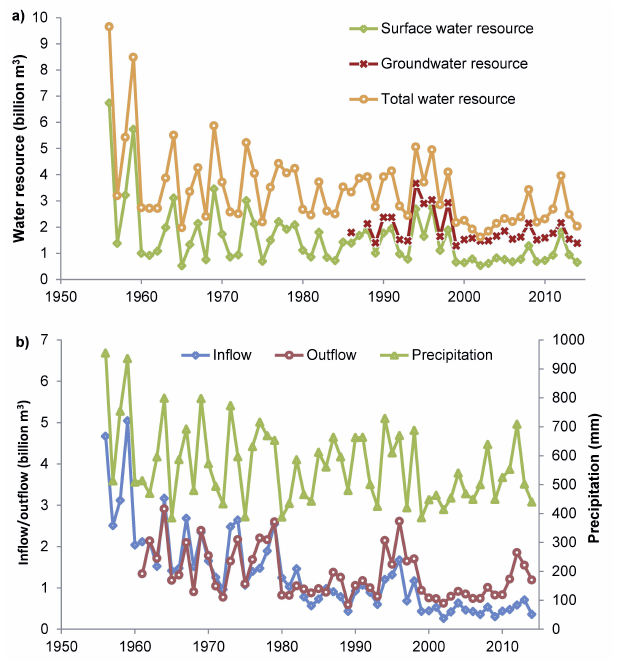
Fig. 3 . Estimates of (a) surface water and groundwater resources, along with the total of these two, in Beijing, and (b) precipitation, inflows, and outflows of reservoirs. Inflows and outflows refer to streamflows. Data from Water Resource Administration Division of Beijing Water Resource Bureau and Beijing Water Resource Bulletin 1986–2015.